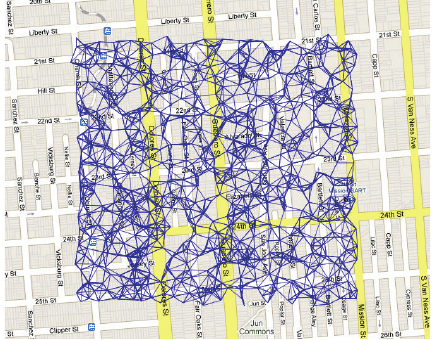
Figure 2: Connectivity graph over 716 sensor nodes where links are shown for PRR ≥ 75%. The average radio range is 36.2